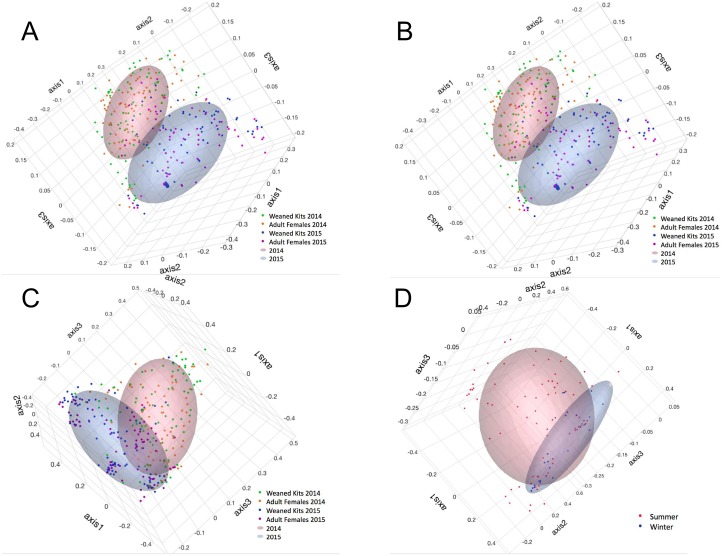
Principal coordinate analysis (PCoA) of community population based on the Jaccard Index (a and b) and community structure based on the Yue-Clayton Index (c and d) of the fecal microbiota of commercial mink, by year (n = 332) (a and c) and season (n = 117) (b and d).Samples were obtained from 43, 46, and 39 farms in 2014, 2015, and 2016, respectively.